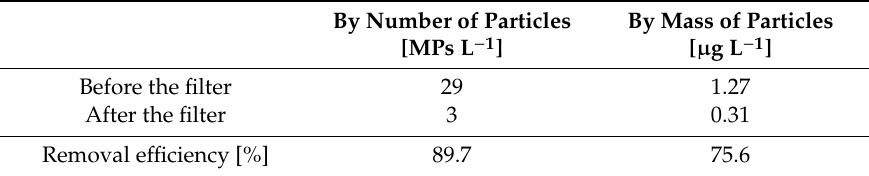
Table 2. Removal e ffi ciency of the disc filter. Concentration of MPs in mass and number of particles in e ffl uent wastewater before it entered the filter of 18 µ m pore size, and after leaving the disc filter. The particles were collected on 10 µ m filter meshes from the